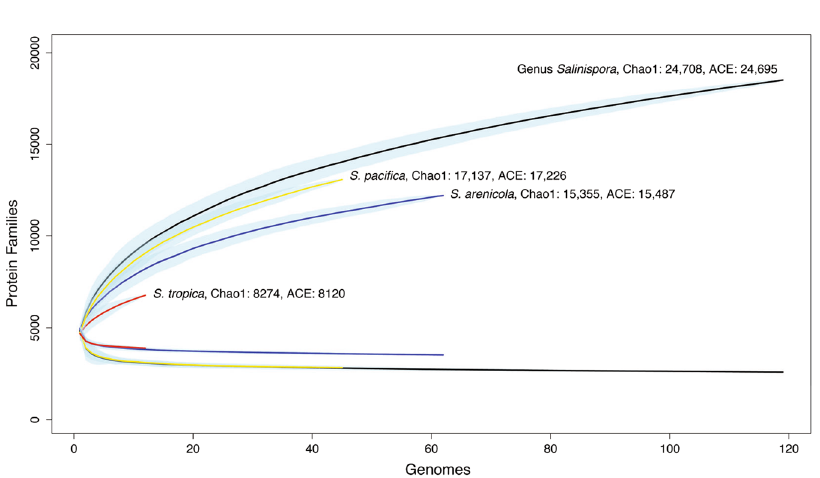
Figure 2. Rarefaction curves. Orthologous groups (protein families) plotted vs. the number of sequenced genomes. Core genomes (lower curves) and pan-genomes (upper curves) are shown for the genus and each species. Black: genus, red: S . tropica , blue: S . arenicola , yellow: S . pacifica . Blue shading indicates standard error. Diversity estimates using Chao1 and ACE are